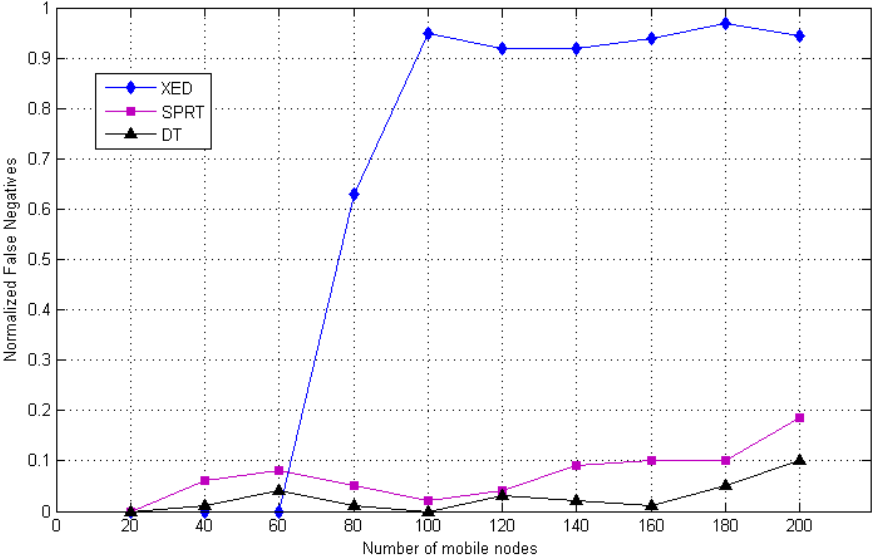
Figure 16. Comparison of simulated value of false negative rate of the DT (hybrid) detection with SPRT and